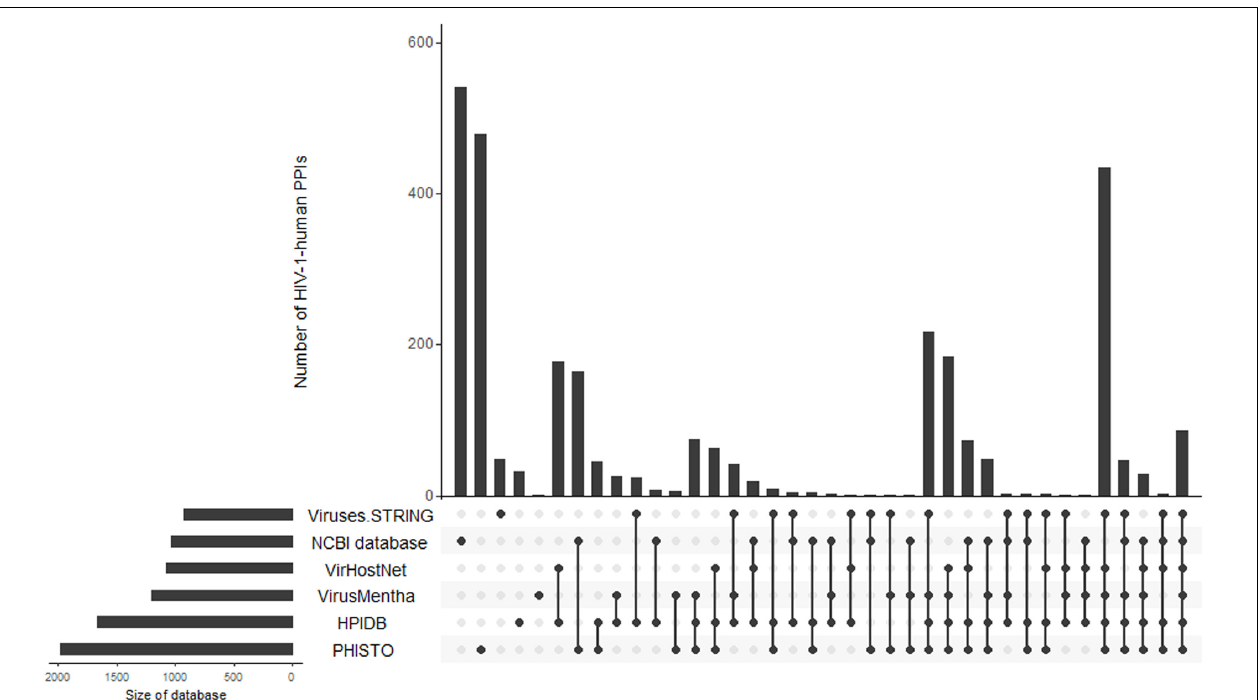
FIGURE 1 | Intersections of HIV-1-human PPIs between six databases. Y -axis represents the numbers of HIV-1-human PPIs, which are either unique for a particular database or shared by two, three, four, five, and six databases. The connections between circles at the bottom part of figure represent intersections of PPIs between databases. The unconnected circles represent PPIs, which are unique for a particular database. The horizontal bars represent the total numbers of HIV-1-human PPIs in each database. TABLE 2 | Distribution of the numbers of PPIs between different HIV-1 groups and subtypes. Number of Range of PPI numbers Number of unique Databases isolates for different isolates 1 PPIs 2